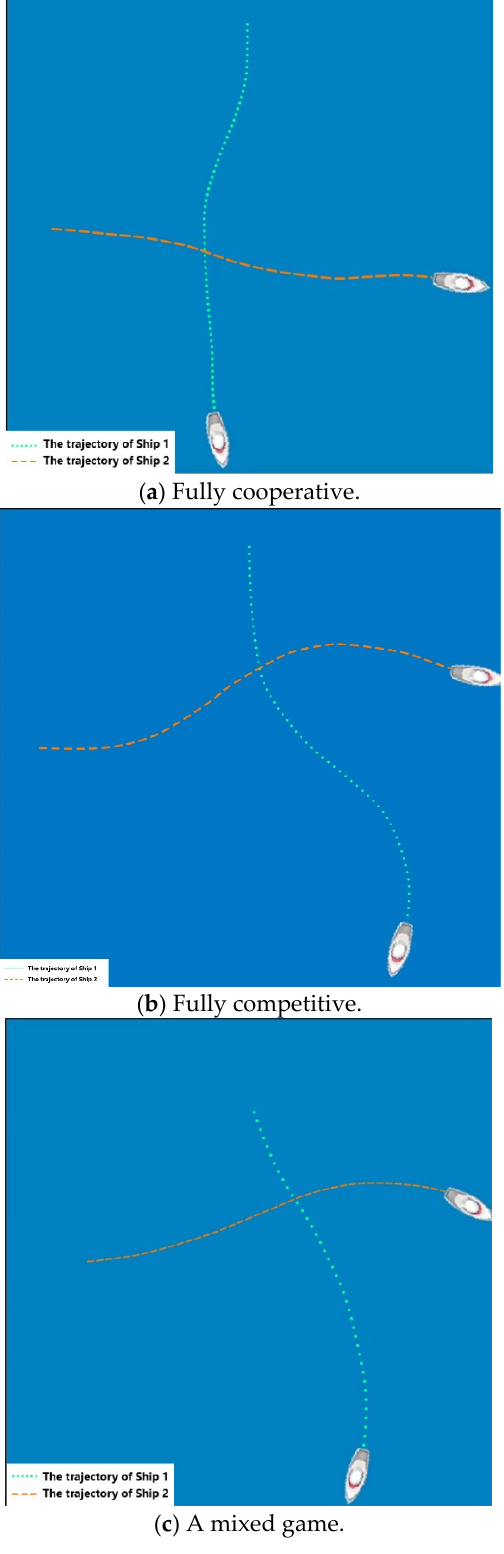
Figure 5. The trajectories of ship agents in collision avoidance process of crossing.